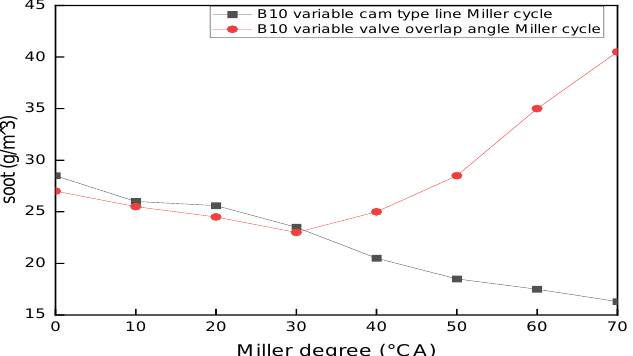
the Miller degree of 30 ◦ CA is also the turning point of soot emission of the diesel engine after power and torque.